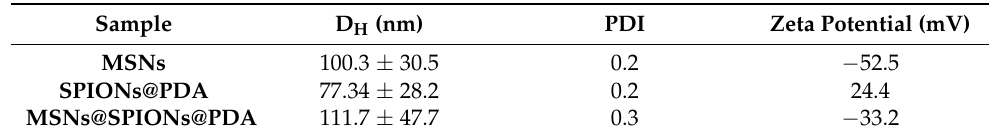
Table 1. DLS characterizations of nanostructures: hydrodynamic diameter (D H ), polydispersity index (PDI) and zeta potential.